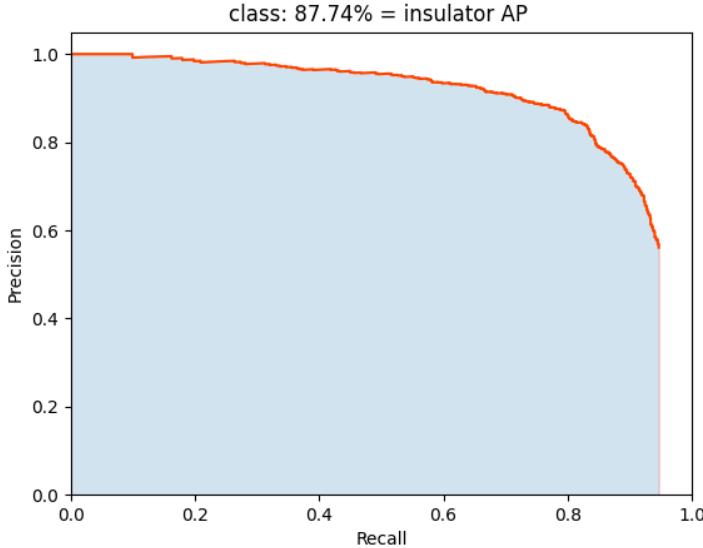
Figure 4. Precision–recall